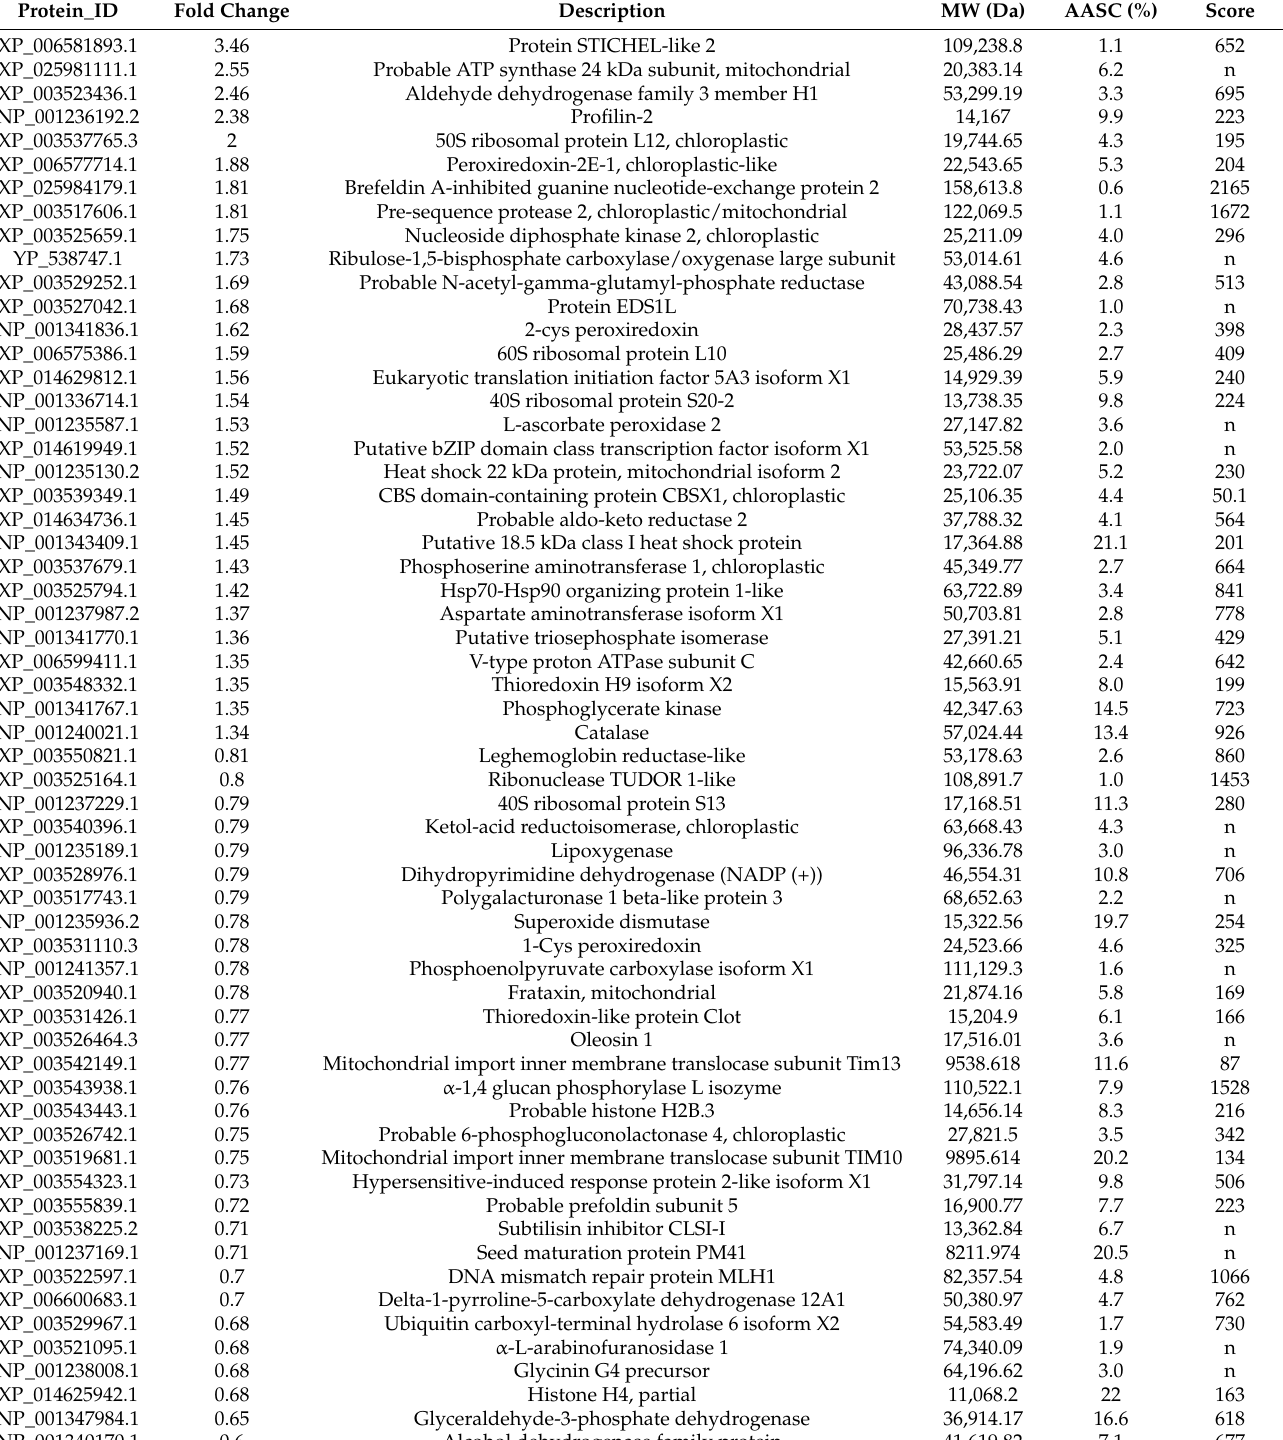
Table 1. Differentially abundant proteins in seeds of Cixidabaican (CX) compared with those in Lingxiyicun (LX). Protein_ID Fold Change Description